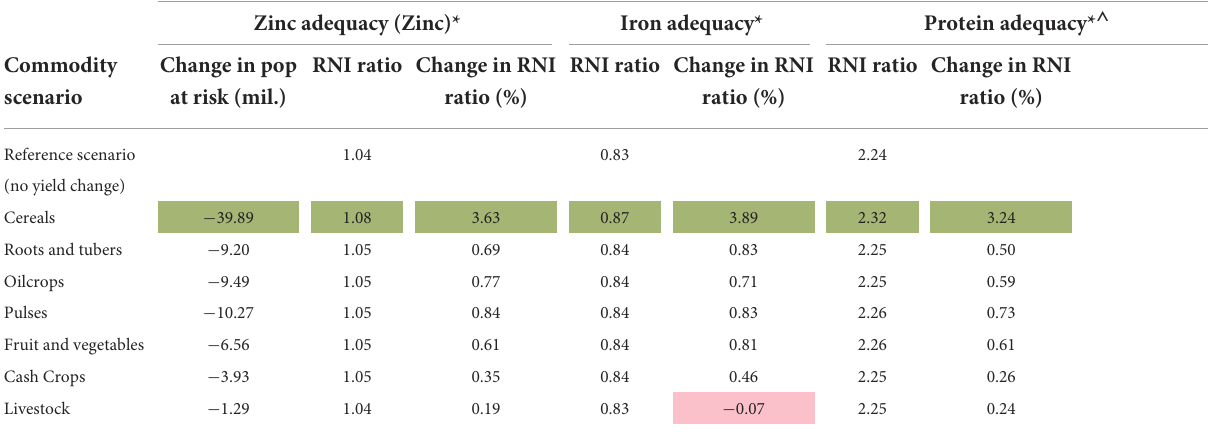
TABLE 4 Agricultural productivity and nutritional change in target